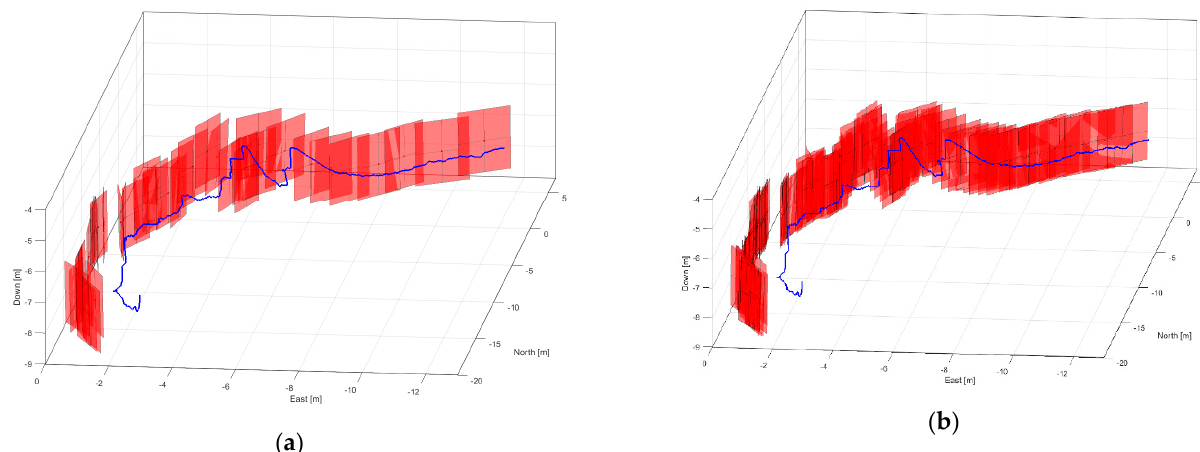
Figure 16. A 3d view of the measured planes. The DVL data is in ( a ), laser data in ( b ).